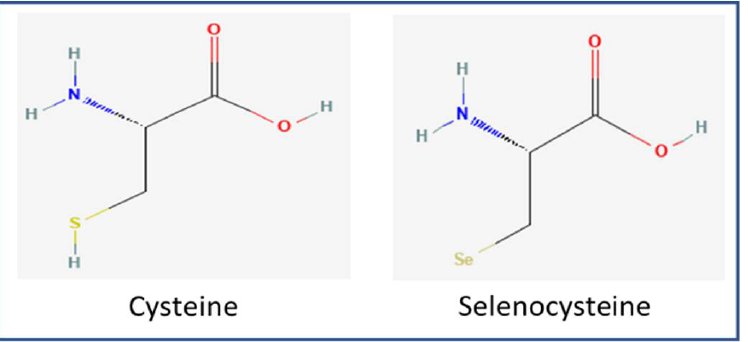
Figure 1. Chemical structure of cysteine (MW: 103.01 Da; PubChem CID: 5862) and selenocysteine (MW: 168.05 Da; PubChem CID: 6326983) [35]. Human selenoproteins broadly can be classified into two groups based on the position of Sec amino acid in selenoprotein. In a group, I Sec is positioned at the C-terminal region, while in a group, II Sec is positioned at the N-terminal region. Group I includes thioredoxin reductases (TrxR), Selenoprotein I (SelI), SelK, SelO, SelR, and SelS, while Group II includes